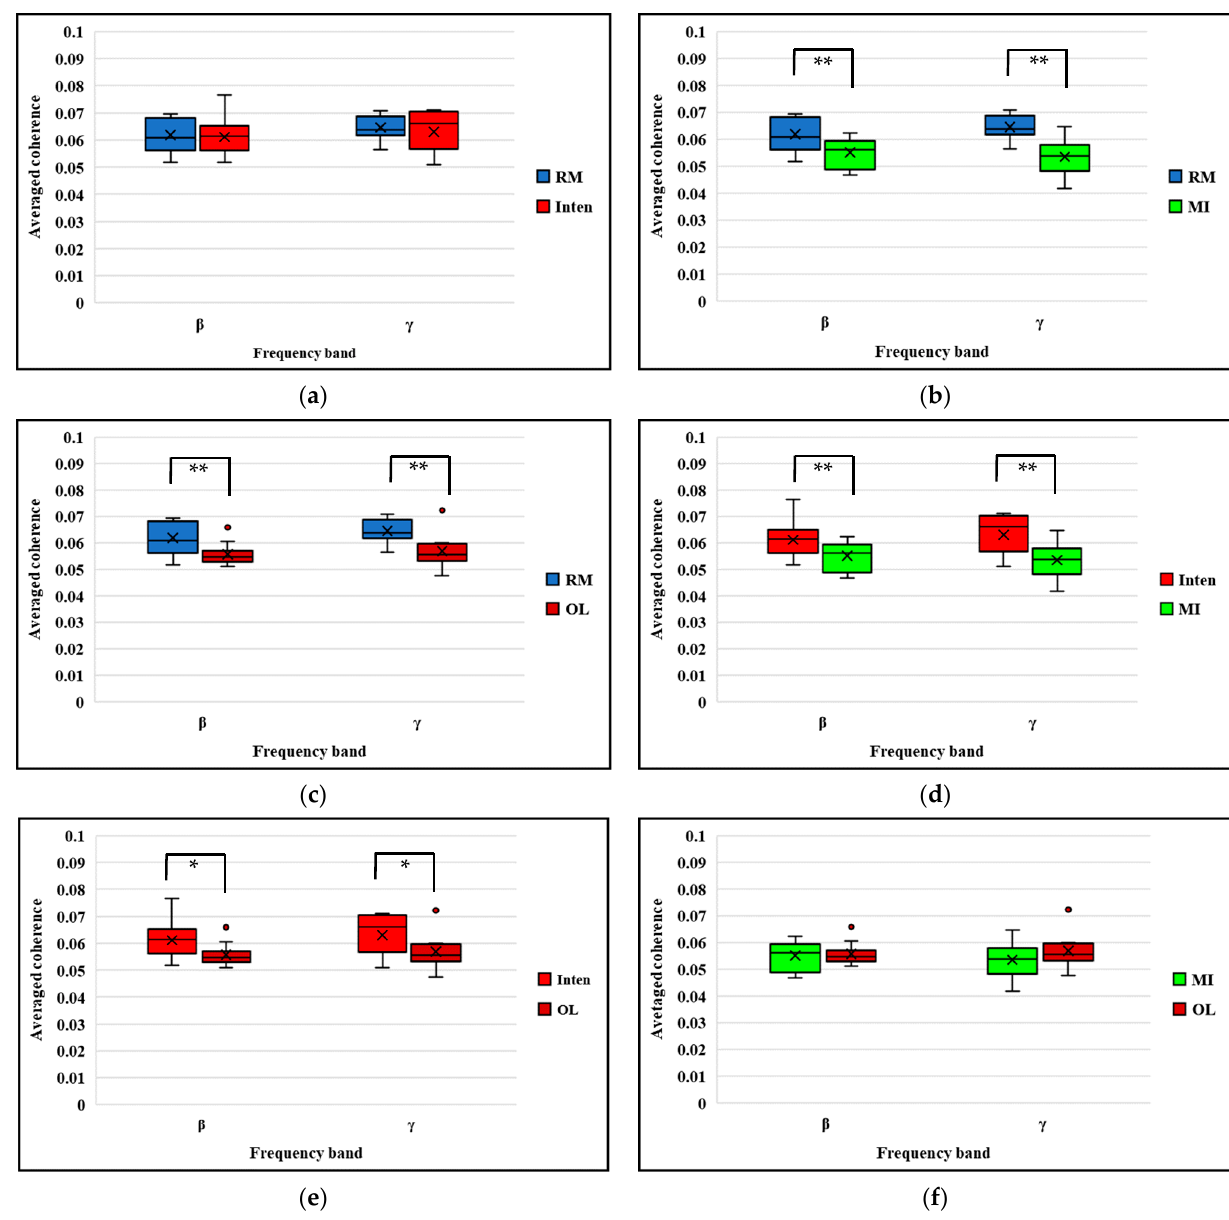
Figure 7. EEG-EMG coherence comparison across all subjects in beta band and gamma band: ( a ) RM task versus Inten task; ( b ) RM task versus MI task; ( c ) RM task versus OL task; ( d ) Inten task versus MI task; ( e ) Inten task versus OL task; ( f ) MI task versus OL task. * p < 0.05 ** p < 0.01.